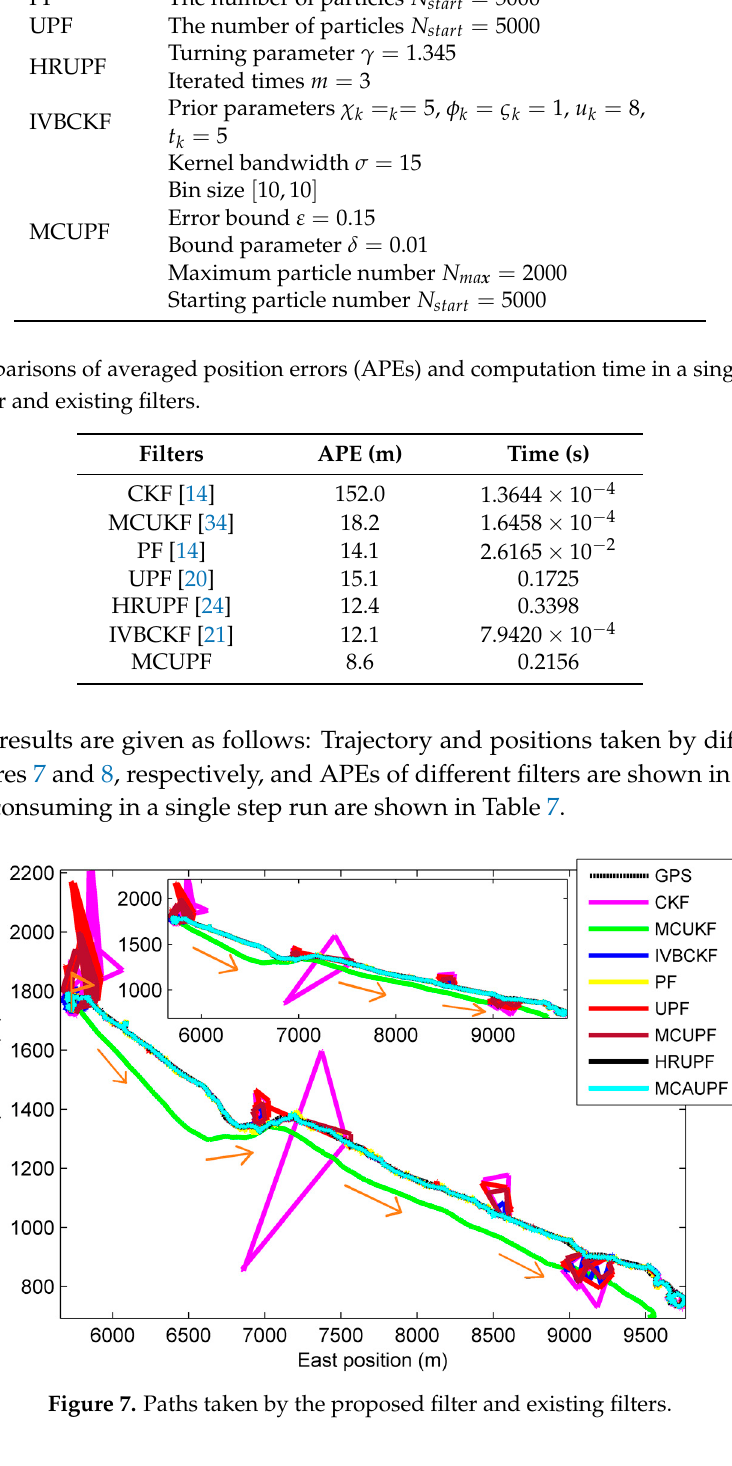
Figure 8. Position of AUV taken by the proposed filter and existing filters.